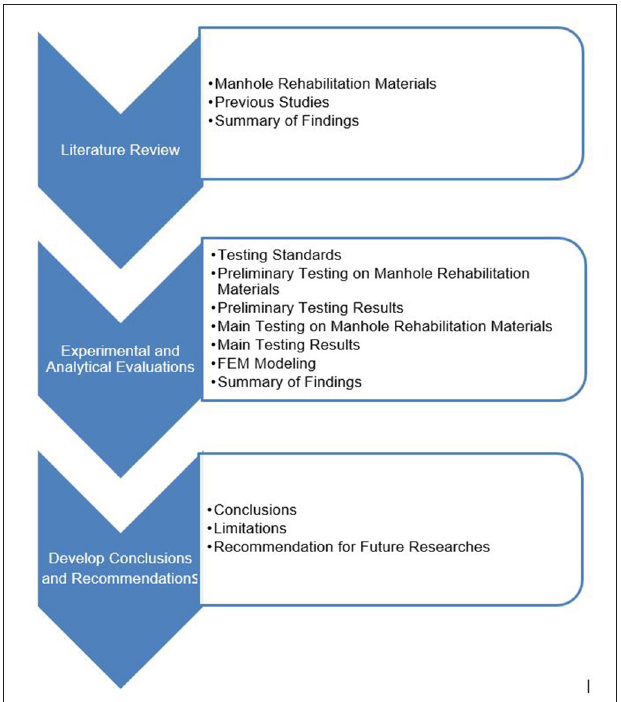
FIGURE 4 | Concrete cylinder (A) and beam (B) samples lined with cured-in-place liner.